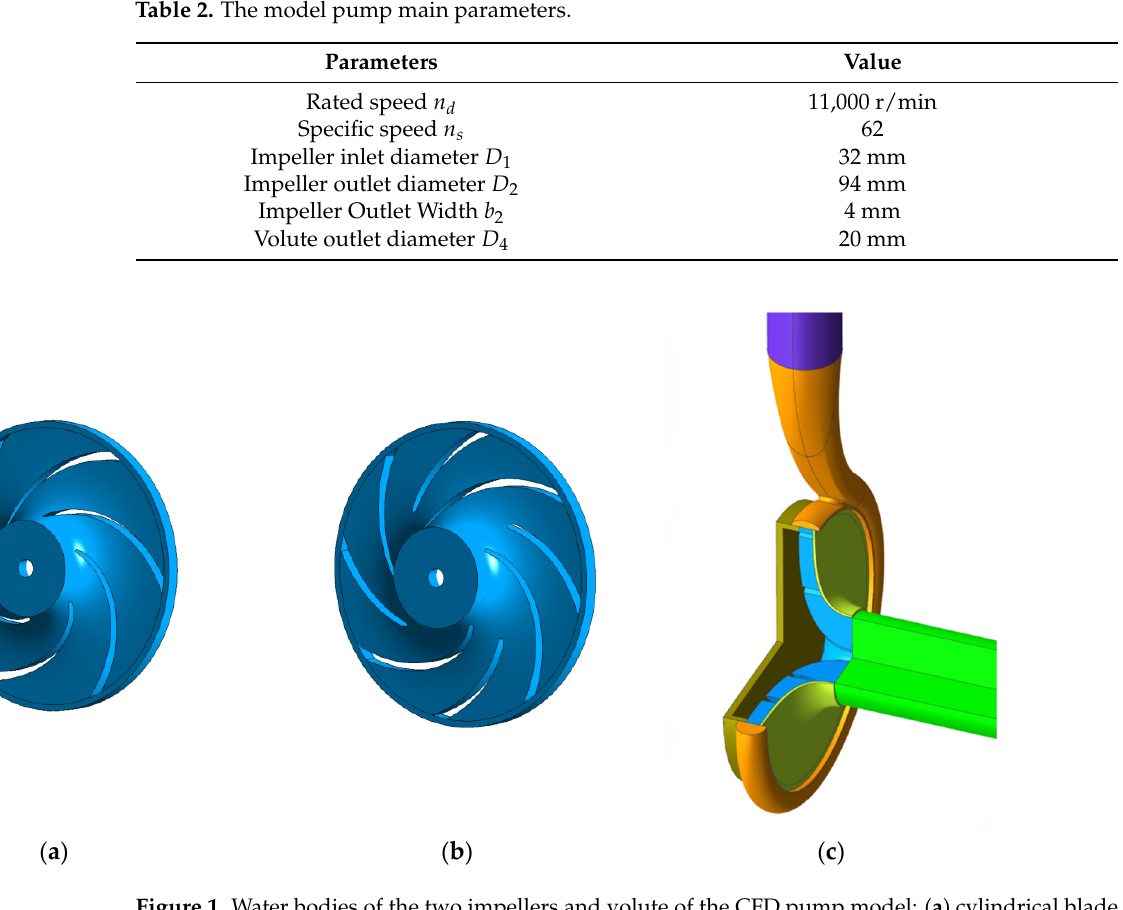
Table 1. Design parameters of the aeronautic cooling pump.